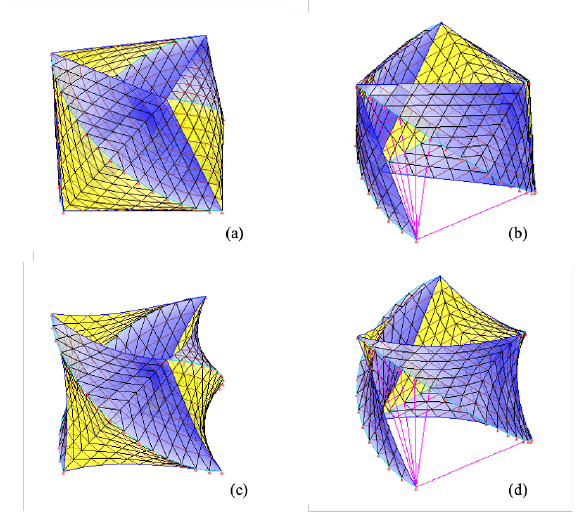
Figure 6: Snapshot of the WinTess model before form-finding (a, b) and after form-finding (c, d) for the closed and open version of the structure.